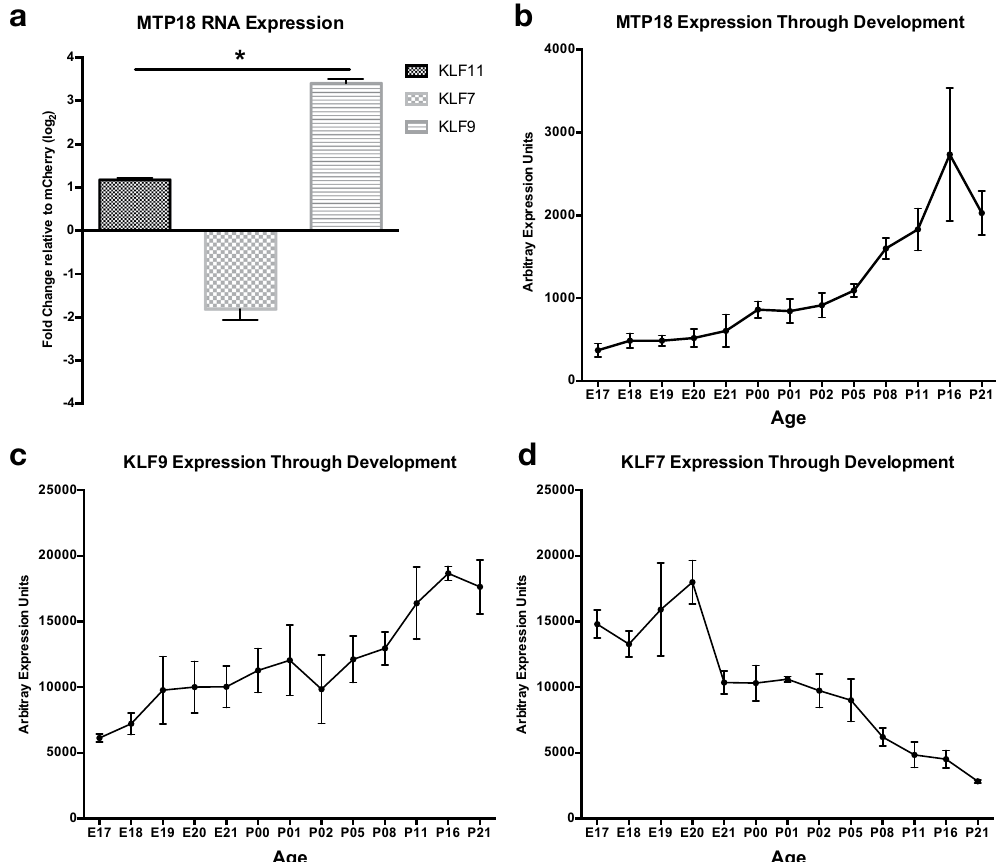
Figure 2. MTP18 expression is regulated in RGCs by KLFs and through development. ( a ) MTP18 mRNA expression after lentivirus mediated KLF 11, -7 and -9 expression, in P4 isolated RGCs, relative to mCherry expressing controls (N = 5 or more independently repeated experiments). Data presented as mean expression, + SEM, identified using multiple microarray chips (significance ascribed by one-way ANOVA and Tukey multiple comparison, * p ≤ 0.05). Relative change in mRNA expression of ( b ) MTP18, ( c ) KLF9, and ( d ) KLF7, in isolated RGCs from E17-P12 by microarray. All groups are N = 3 or more independently repeated experiments. All Error bars represented as ±